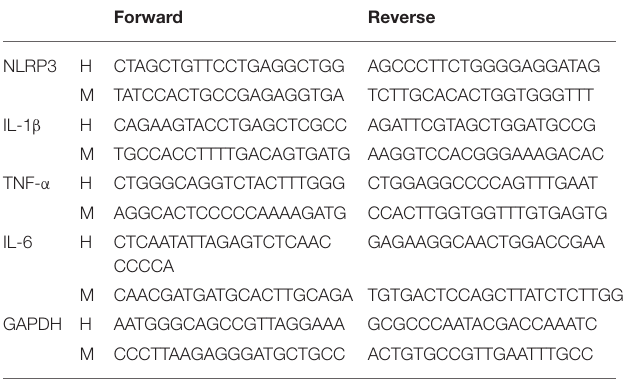
TABLE 1 | Primers used for real-time PCR